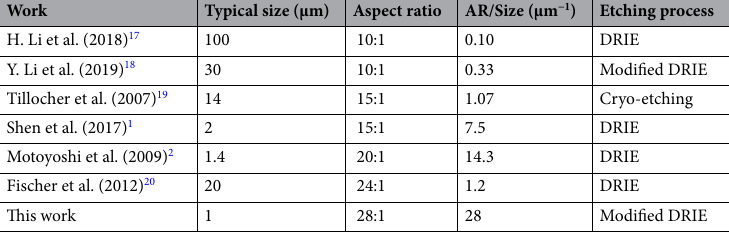
Table 2. Comparison of several deep reactive ion etching processes.